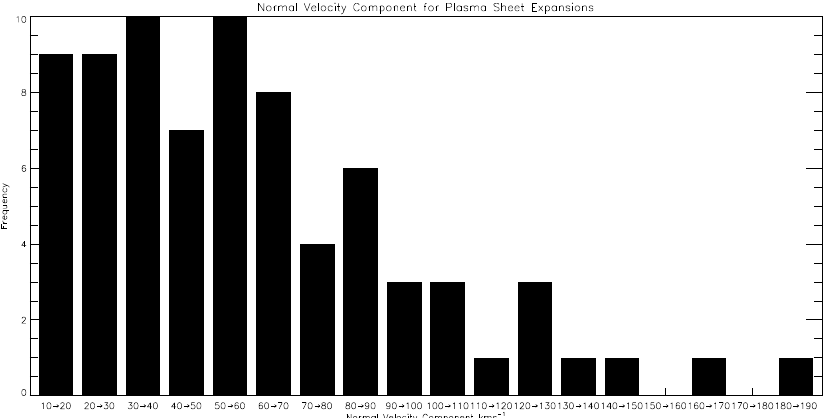
Fig. 16. A bar chart of the normal velocity component of all plasma sheet-lobe boundaries passing over the spacecraft associated with plasma sheet expansion. The speeds are binned into 10kms − 1 bins. The average is 60 ± 37kms − 1 .